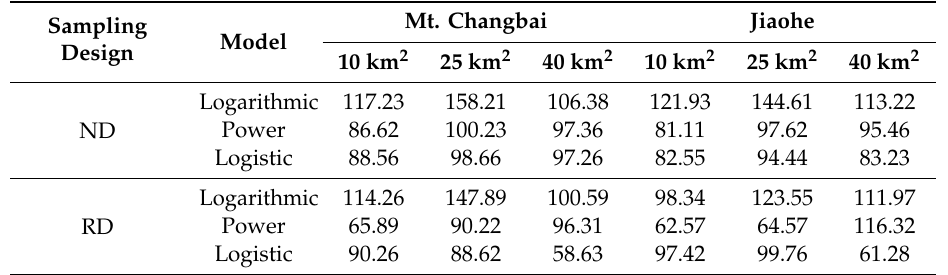
Table 4. The evaluation of the Akaike information criterion for the three species-area models of varying